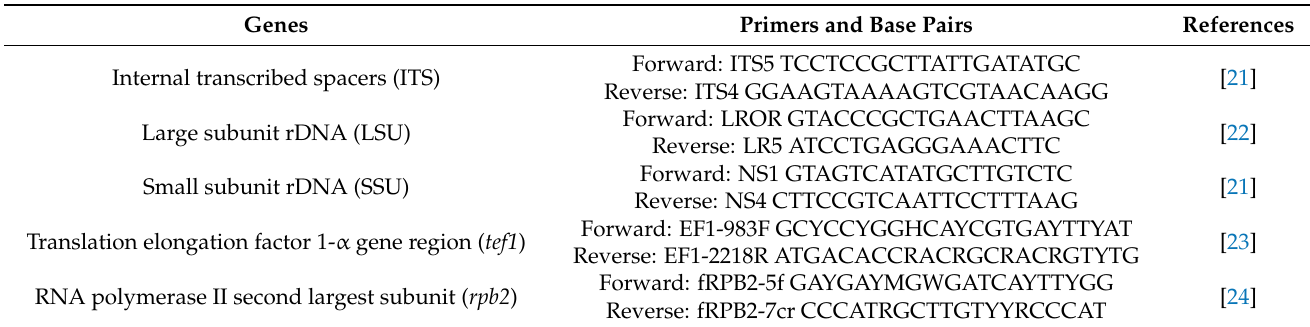
Table 1. ITS, SSU, LSU, tef1, and rpb2 loci primers information.